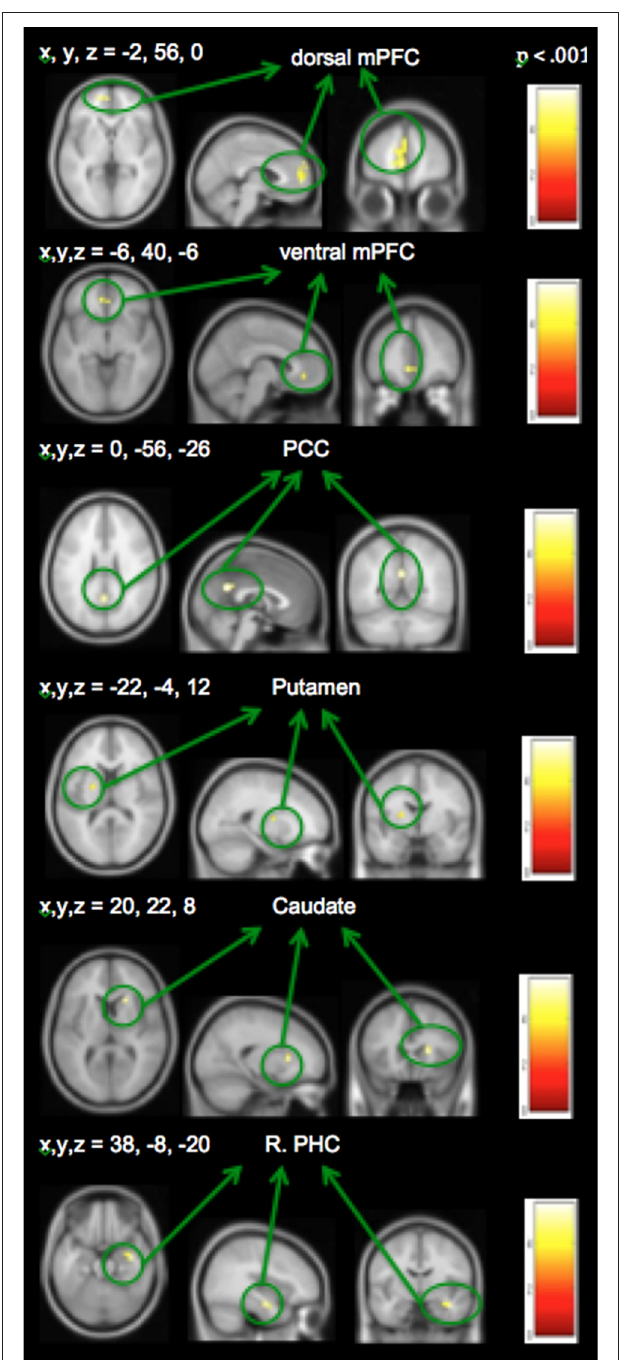
FIGURE 4 | Positive mood preparatory effect: whole-brain analyses revealing regions showing greater signal during positive vs. neutral mood states.